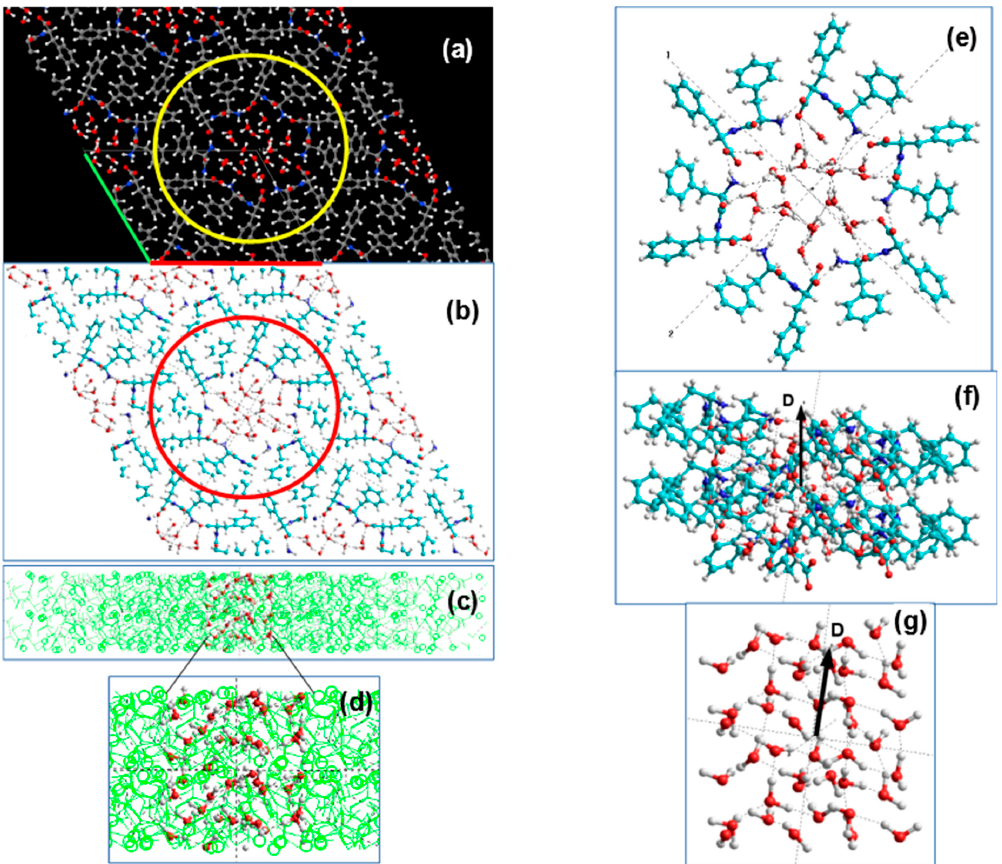
Figure 5. Schematics of the D-FF PNT structures with optimized 21 H 2 O per unit cell embedded water cluster (the designations used are the same as in Figure 4): ( a ) Z-projection image from VASP computed data with four unit cells; ( b ) the same image converted into HyperChem workspace; ( c ) side Y-projection and cross-section of D-FF structures with selected water molecules formed initial water cluster; ( d ) inset with biggest image of water cluster; ( e ) Z-projection image of the D-FF 2 coils with 42 H 2 O embedded water cluster; ( f ) Y-projection image of the D-FF 2 coils with 42 H 2 O embedded water cluster ( D show the total dipole momentum); ( g ) Y-projection image of the 42 H 2 O water cluster extracted from D-FF PNT after optimization ( D shows the total dipole momentum for water cluster).